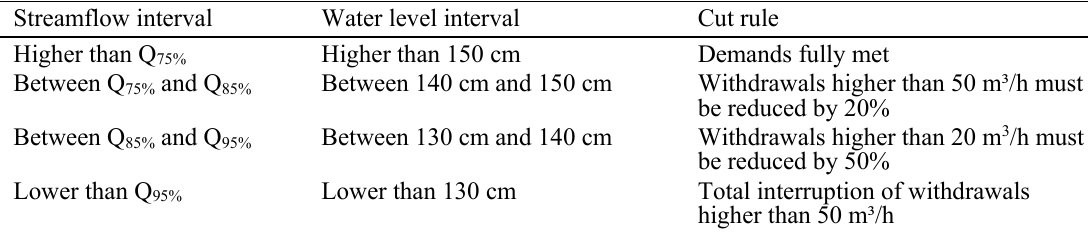
Table 1 Water use rules conditioned on water